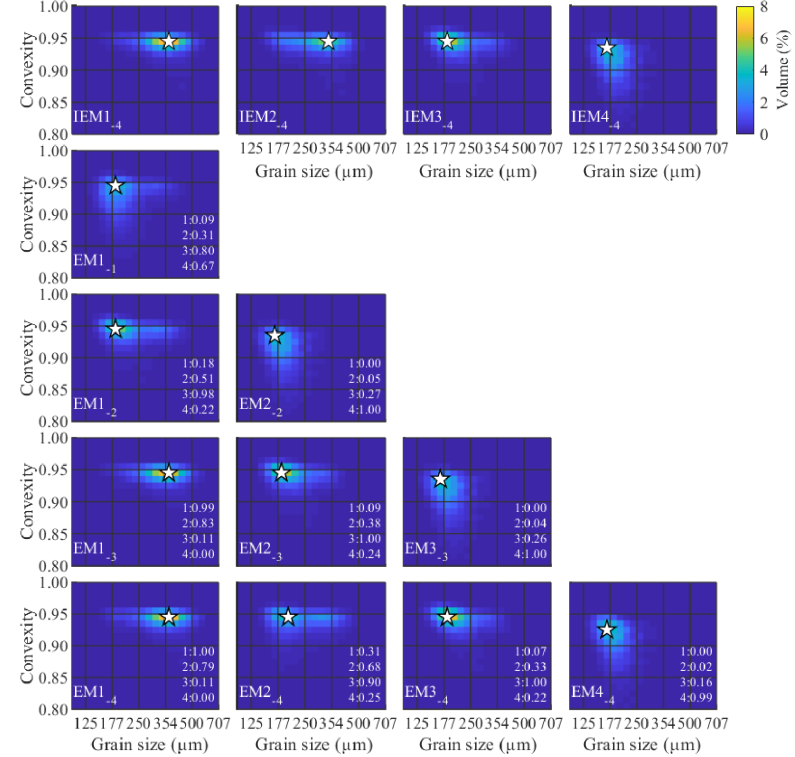
Figure A6. Median class- and sample-wise R 2 versus the number of endmembers for the artificial datasets: 3EM_nonoise (a) , 4EM_noise (b, c) , and 4EM_noise_highmix (d, e) . Panels (c) and (e) zoom in on panels (b) and (d) .